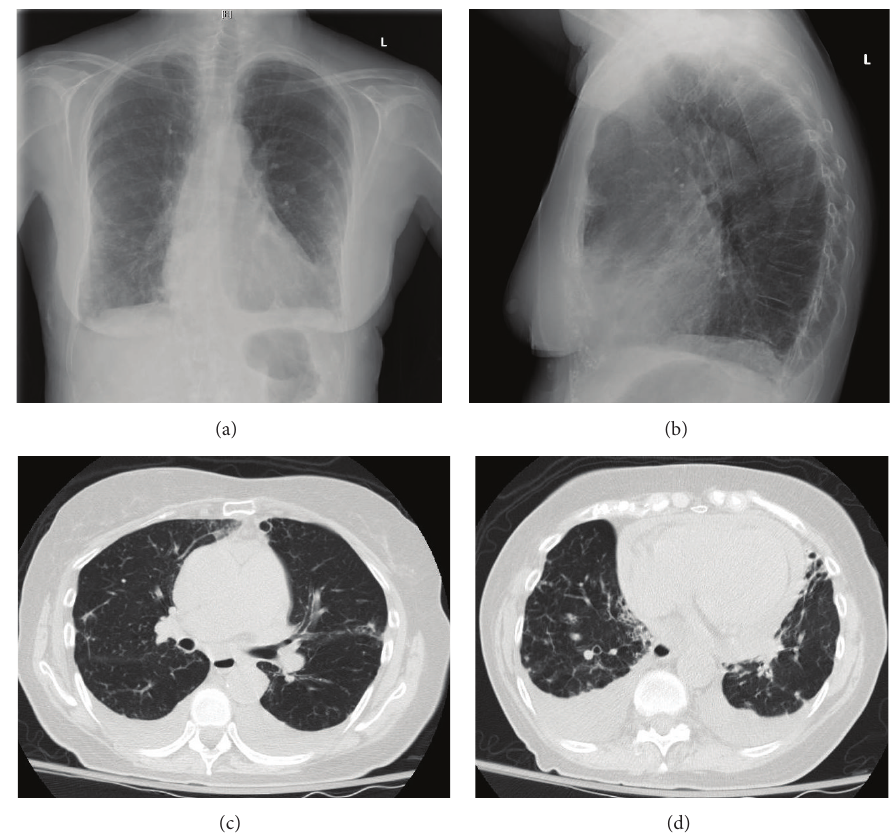
Figure 3: Chest X-ray and chest CT findings in Case 3 . Chest X-ray showing stable bilateral nodular opacities and lower lobe predominant interstitial reticular thickening with new small bilateral pleural effusions (a, b). CT of the chest reveals bronchiectasis in the right middle and lingular lobes (c) and tree-in-bud nodular infiltrates in the bilateral lower lobes with new bilateral moderate pleural effusions.